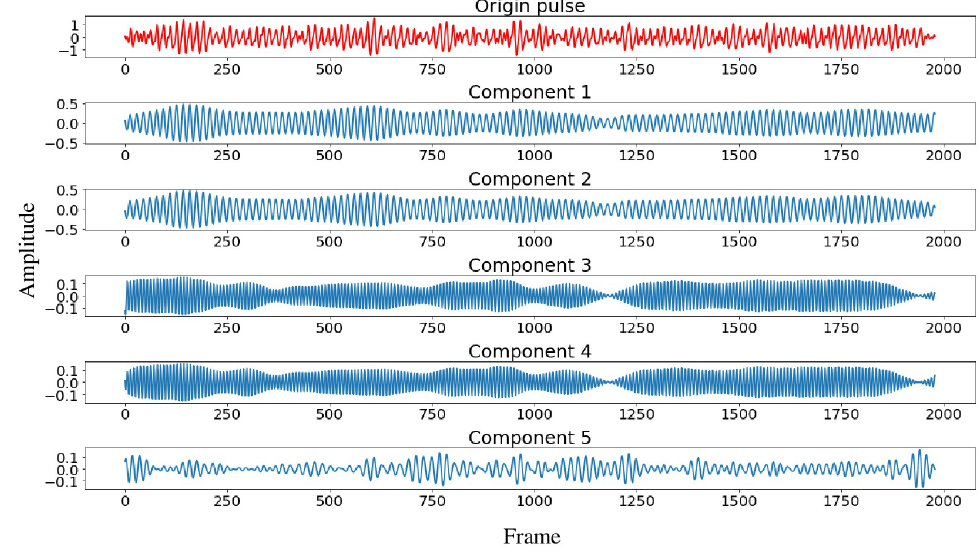
Fig 6. Original signal and its first five components.